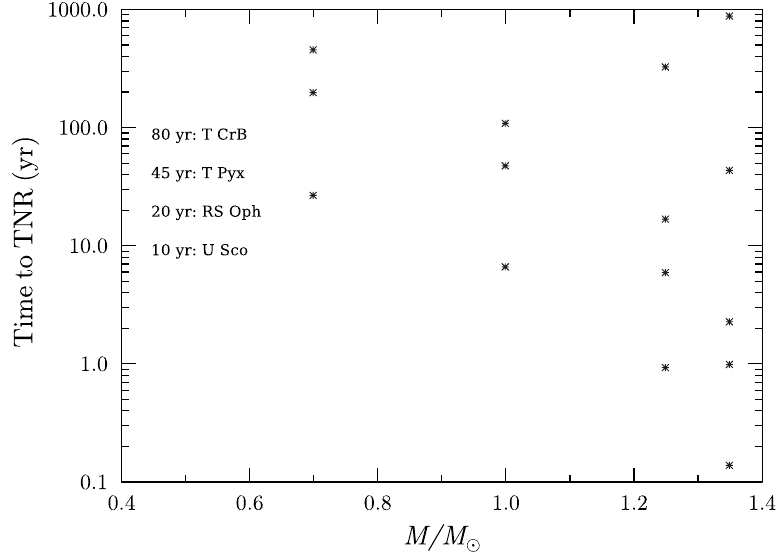
Fig. 4. These are the same data given in Figure 3 but here we concentrate only on the lower right corner and add approximate recurrence times for the best known RNe. The location of each RN on the left hand side of the plot indicates its approximate recurrence time. This plot shows that not only is it possible for RNe outbursts to occur on low mass WDs but they can also occur for a broad range of ˙ M on higher mass